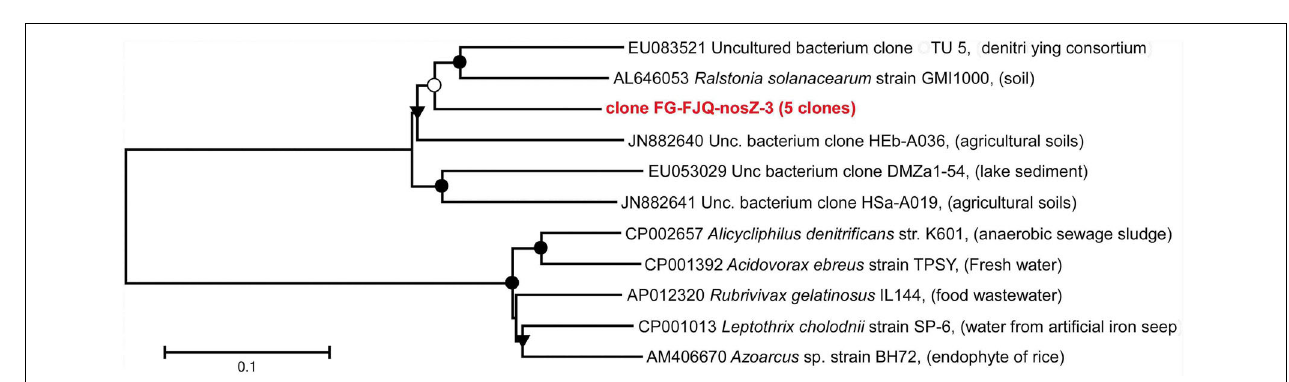
FIGURE 8 | Phylogenetic relationships of clones for nosZ gene gene fragments. The tree was generated by neighbor-joining analysis of 1152 nucleotide positions. Further details are as described in the legend to Figure 3